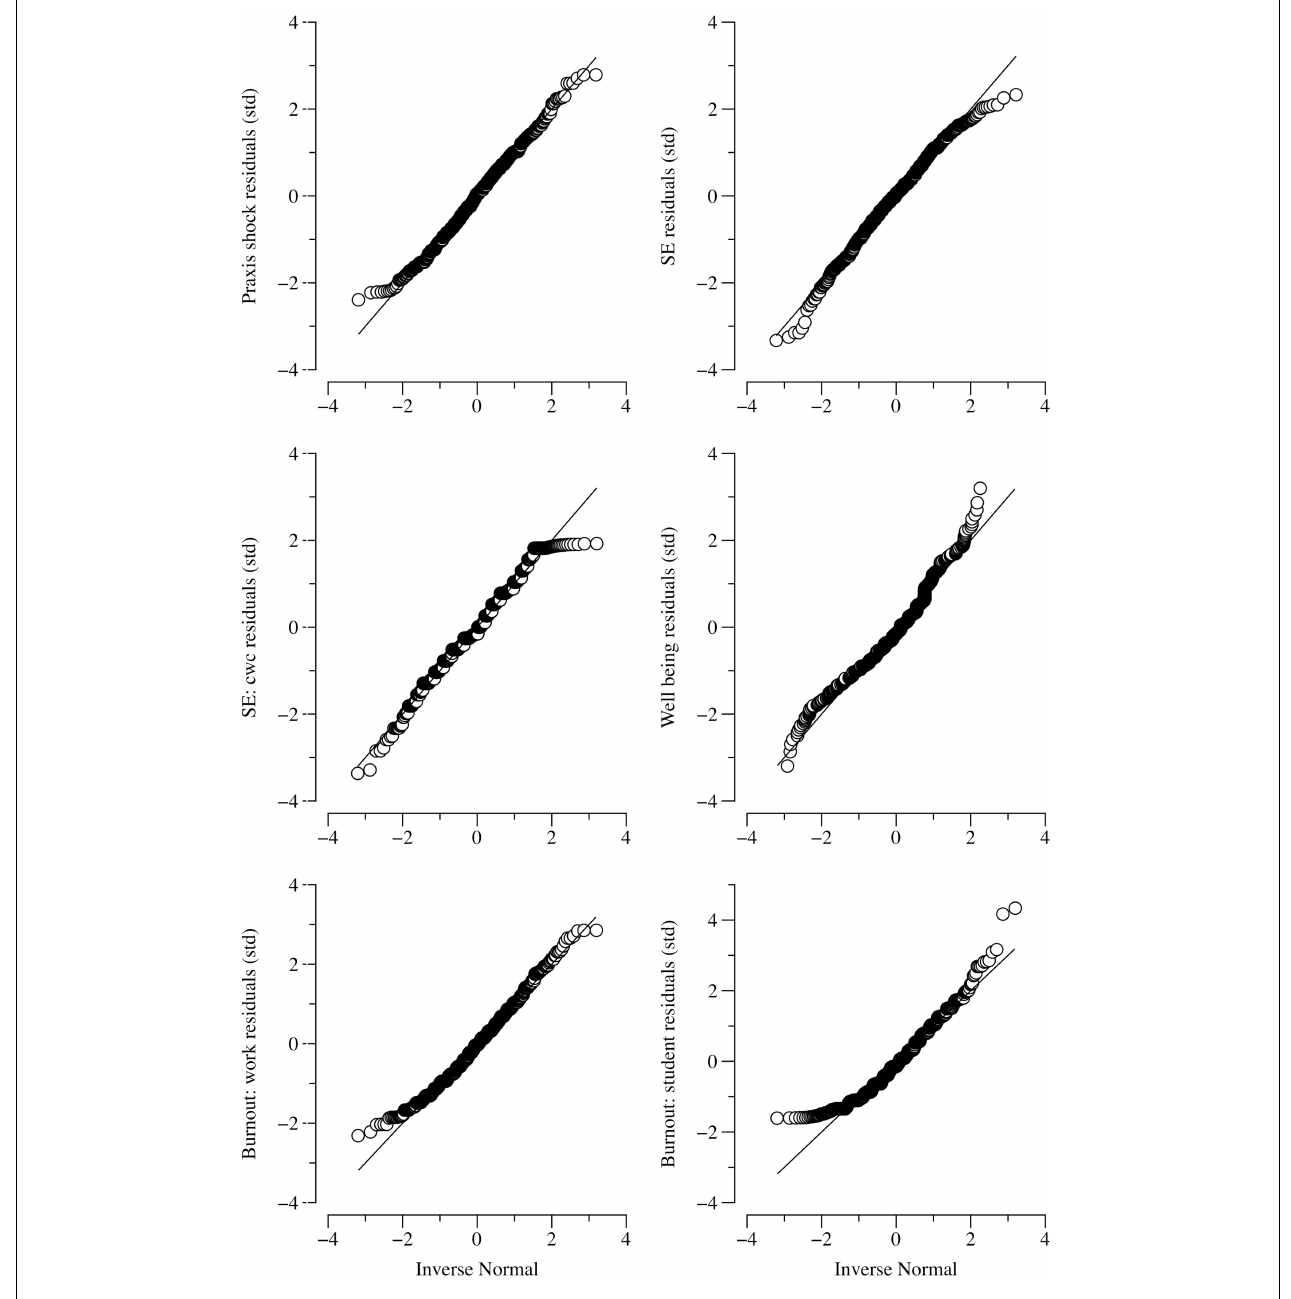
FIGURE 2 | Quantile-quantile plots showing normality fits for all linear